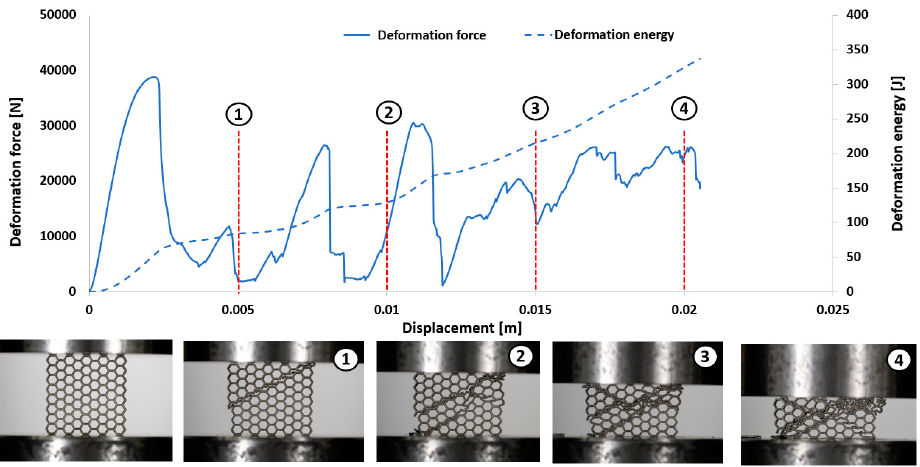
Figure 12. Deformation process of specimen No. 1 manufactured additively with LENS (1 - 4 stages of deformation during static compression test).